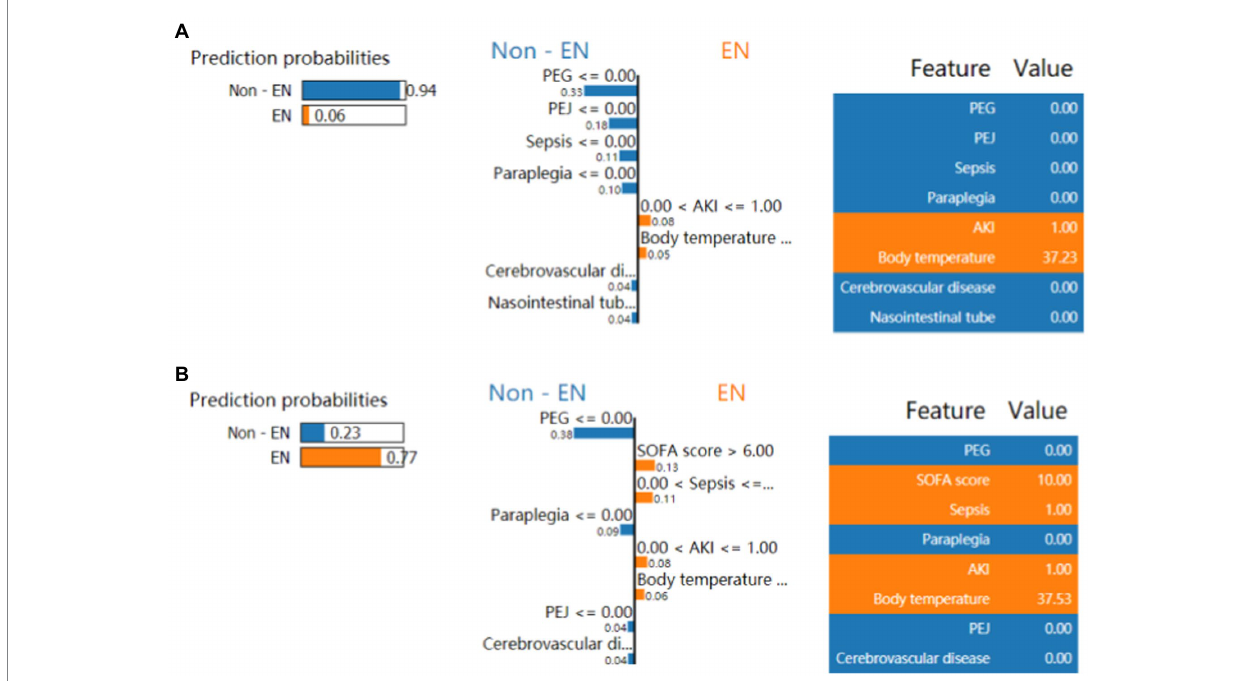
FIGURE 5 LIME algorithm for explaining individualized prediction. (A, B) Showed the risk prediction charts for the use of EN in critically ill patients or not. (A) Presented a Non-EN case with the LIME algorithm. (B) Presented a EN case with the LIME algorithm. The prediction probabilities by LIME are depicted in the left of the two screenshots. The first 8 features that significantly affected on using EN or not are presented in the middle sections from top to bottom. The weight (importance) of each feature in risk prediction is indicated per the bar’s length. The longer bar represents the more contribution to EN initiation or not. The critical values of these 8 features are shown on the right parts when they had the maximize effect on using EN or not. LIME, local interpretable model-agnostic explanations; EN, enteral nutrition; AKI, acute kidney injury; PN, parental nutrition; PEG, percutaneous endoscopic gastrostomy. PEJ, Percutaneous Endoscopic Jejunostomy; SOFA, sequential organ failure